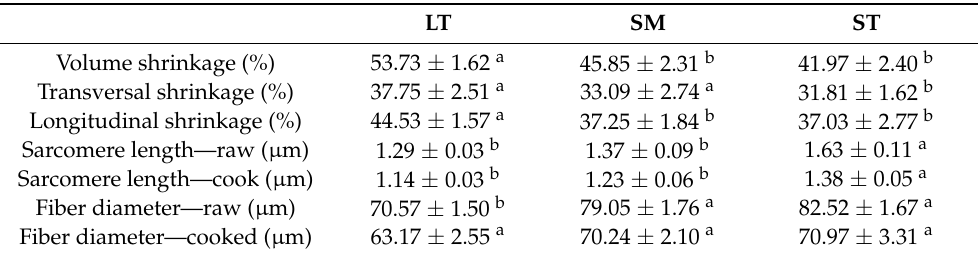
Table 2. Volume shrinkage (means ± SE, n = 11) of porcine longissimus thoracis , semimembranosus and semitendinosus